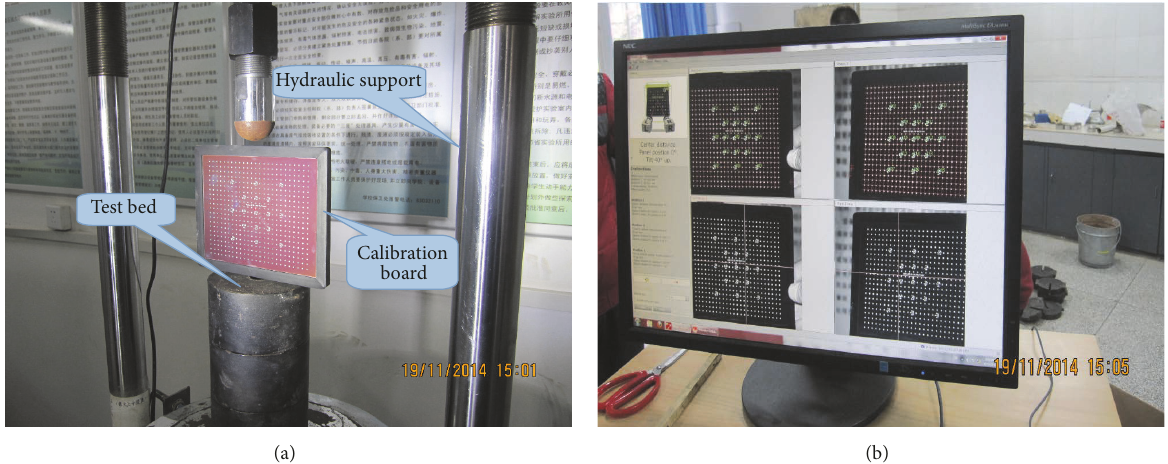
Figure 2: The hydraulic loading system (a) and the calibration of the ARAMIS 3D optical deformation measuring system (b).